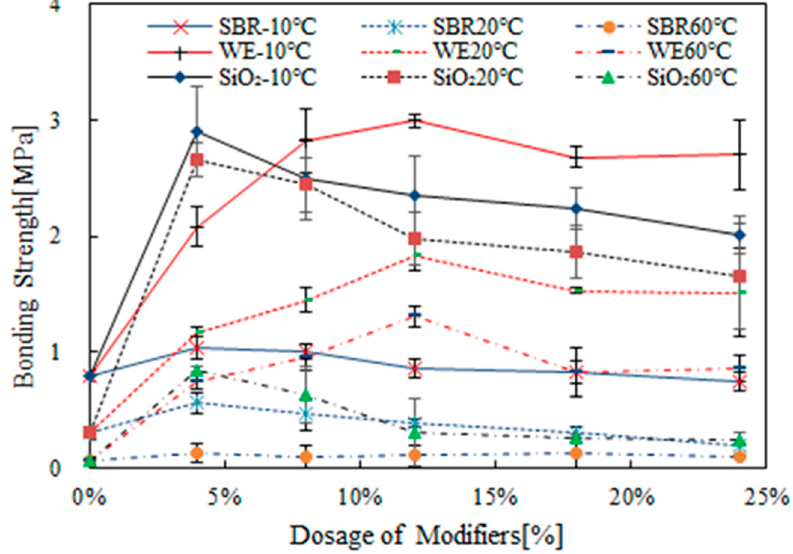
Figure 2. Typical strength–displacement curves of bonding strength tests.